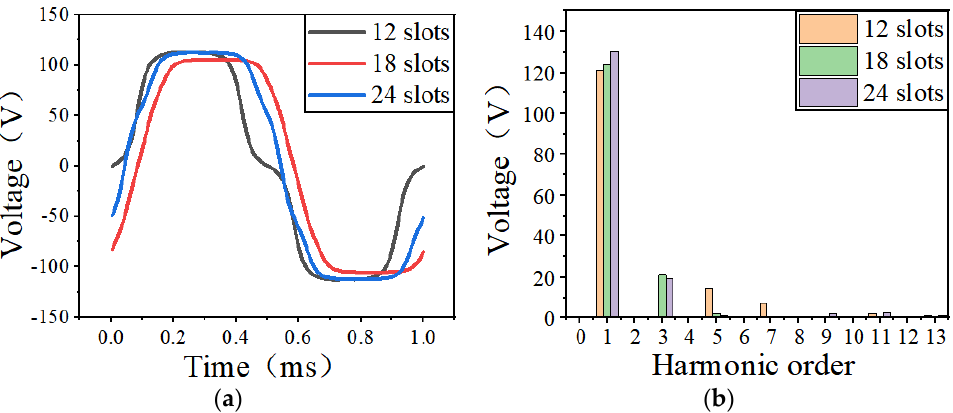
Figure 5. Waveforms and FFT analysis results of back EMF for 12 slots, 18 slots, and 24 slots HSPMMs. ( a ) Waveforms; ( b ) FFT analysis results.